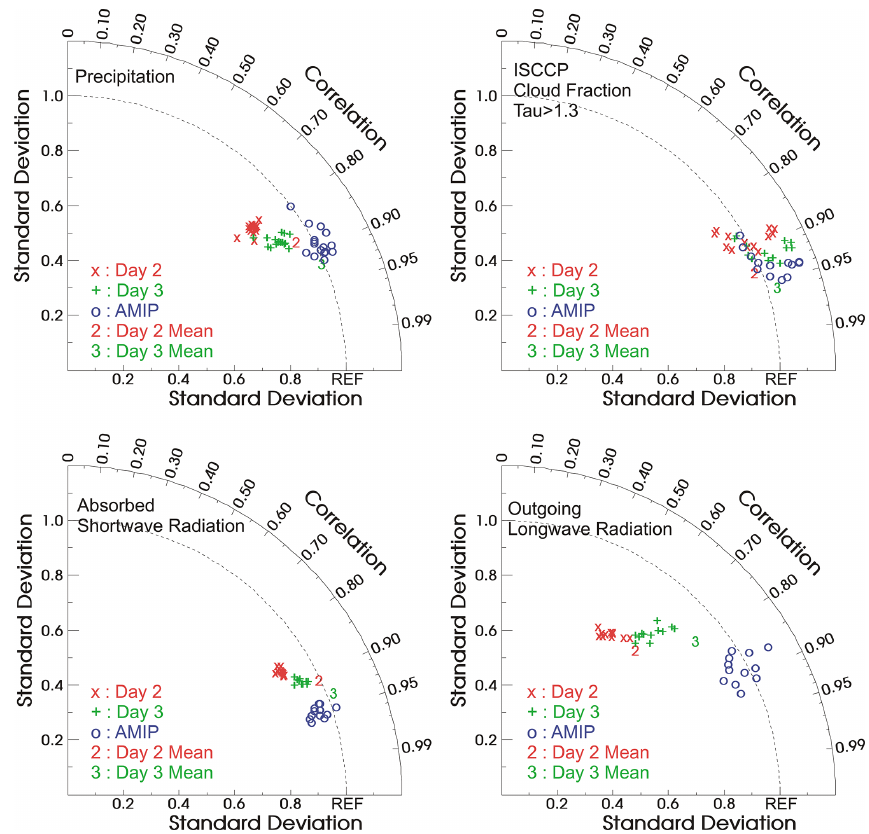
Figure 8. Spatial pattern statistics of the bias errors (with respect to observations) of annual mean precipitation, ISCCP total cloud fraction (with τ > 1.3), absorbed shortwave radiation, and outgoing longwave radiation from the multi-year CAM5 hindcasts and an AMIP simulation. These statistics are illustrated with a Taylor diagram (Tayler, 2001) that shows the level of agreement of a given field to a common reference. The reference fields (REF) are the correspondent multi-year mean bias errors from the AMIP simulation. Each “x”, “ + ”, or “o” represents the day 2, day 3, or AMIP annual mean bias for individual years between 1997 and 2012 whenever the observations are available, and “2” and “3” represent the day 2 and day 3 hindcast mean biases averaged over all available years,